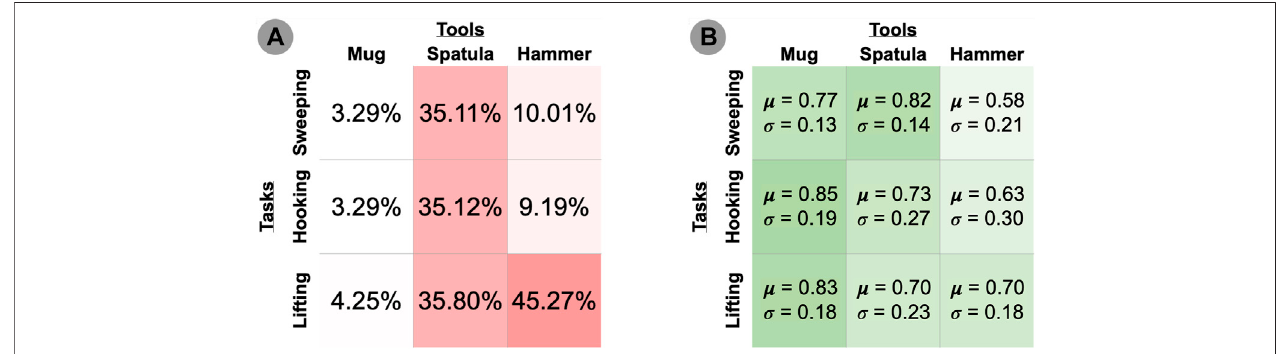
FIGURE 5 | Performance distributions over all tool-task pairings, with all trials with performance ≤ 0.05 excluded. X - and Y -axes are consistent across all graphs.